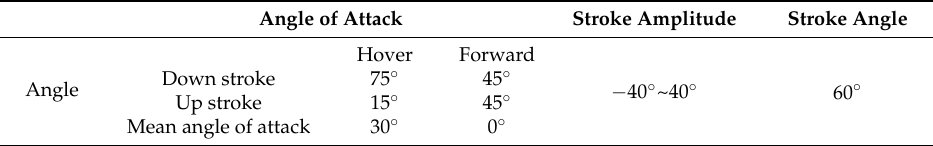
Figure 1. Coordinate system of flapping motion. Table 1. Kinematics of dragonfly for experiment.